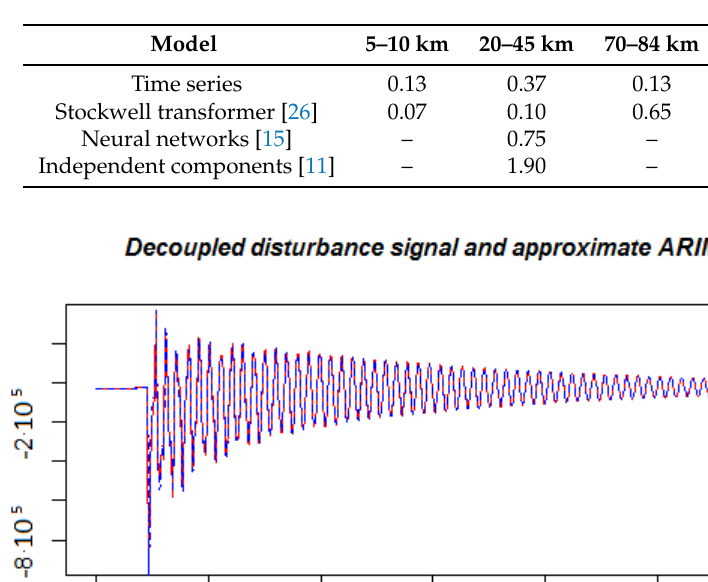
Table 4. Comparison between models through the Error value (Equation (18)).